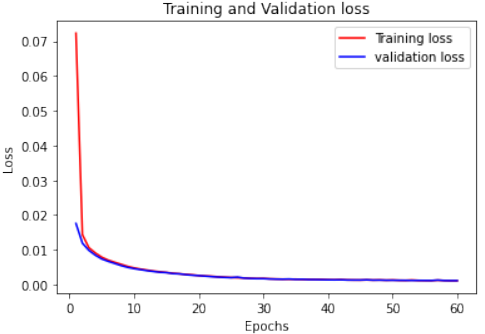
Figure 5. Training and validation loss of autoencoder.